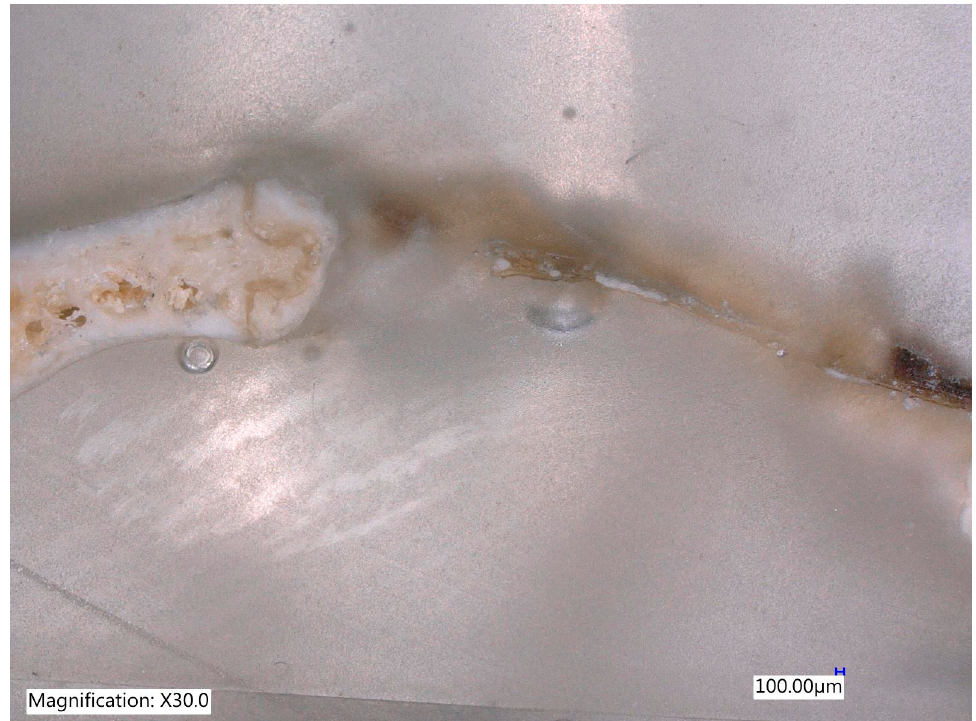
Figure 11. The control site after an 8-week of follow up with complete healing without bone formation (Magnification 30×). Materials 2019 , 12 , x FOR PEER REVIEW